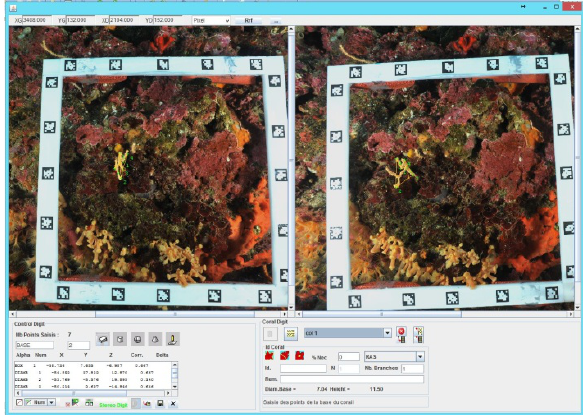
Figure 8. Stereo interface for manual plotting. The user can benefit from auto correlation with epipolar constraint, epipolar line, management of already measured object, and the belonging observation, consistency